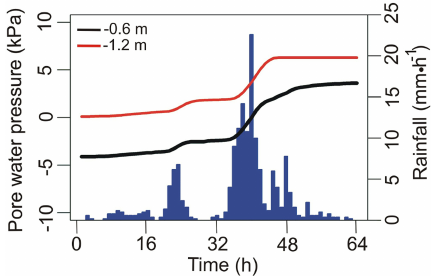
Figure 11. Pore water pressure modelled by TRIGRS-unsaturated for 27–28 April 2009 event corresponding to the monitoring station in the study